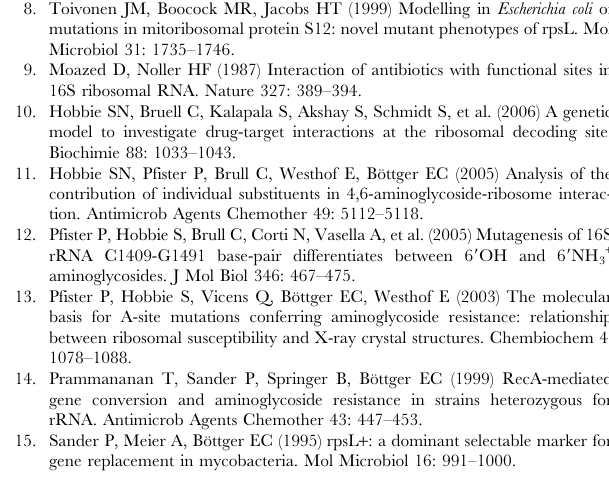
a two-step selection procedure: selection of transformants on agar plates containing gentamicin followed by a counter-selection step on agar plates with sucrose. Deletion of rrnB was confirmed by Southern blot analysis and partial sequencing.